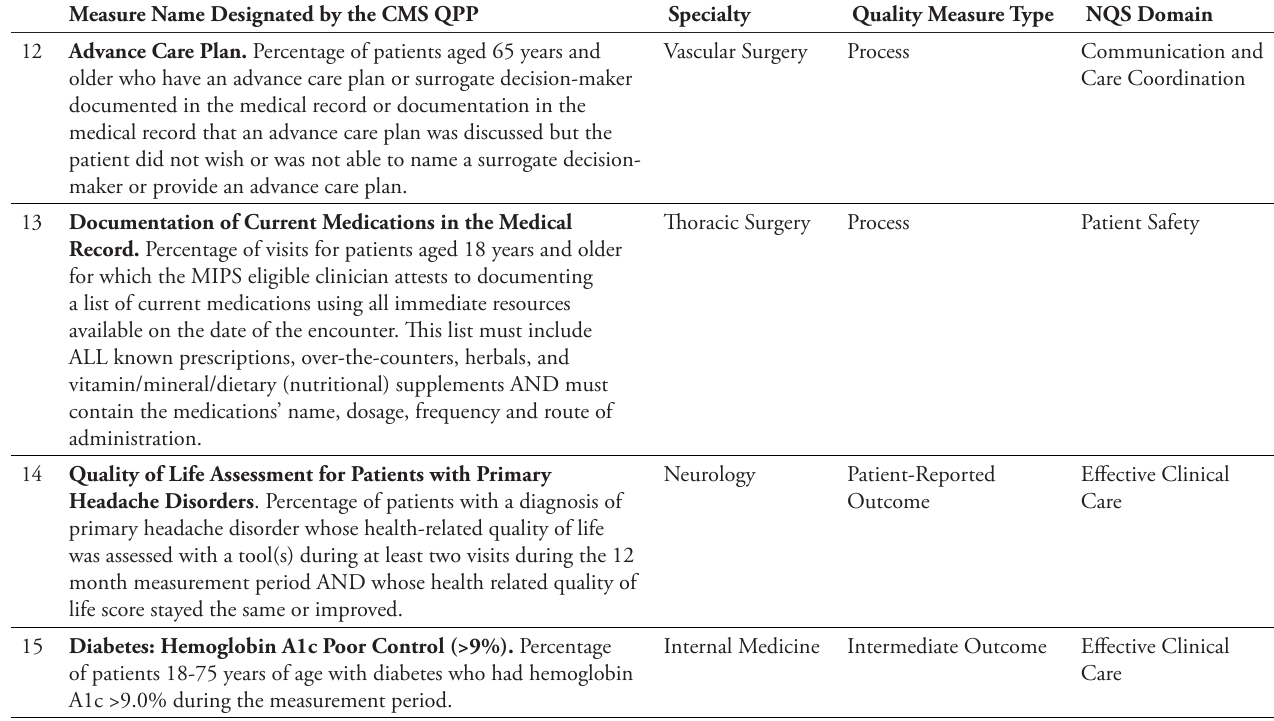
Table 3. Clinical Specialties, Quality Measure Types and NQS Domains of Select MIPS Measures Measure Name Designated by the CMS